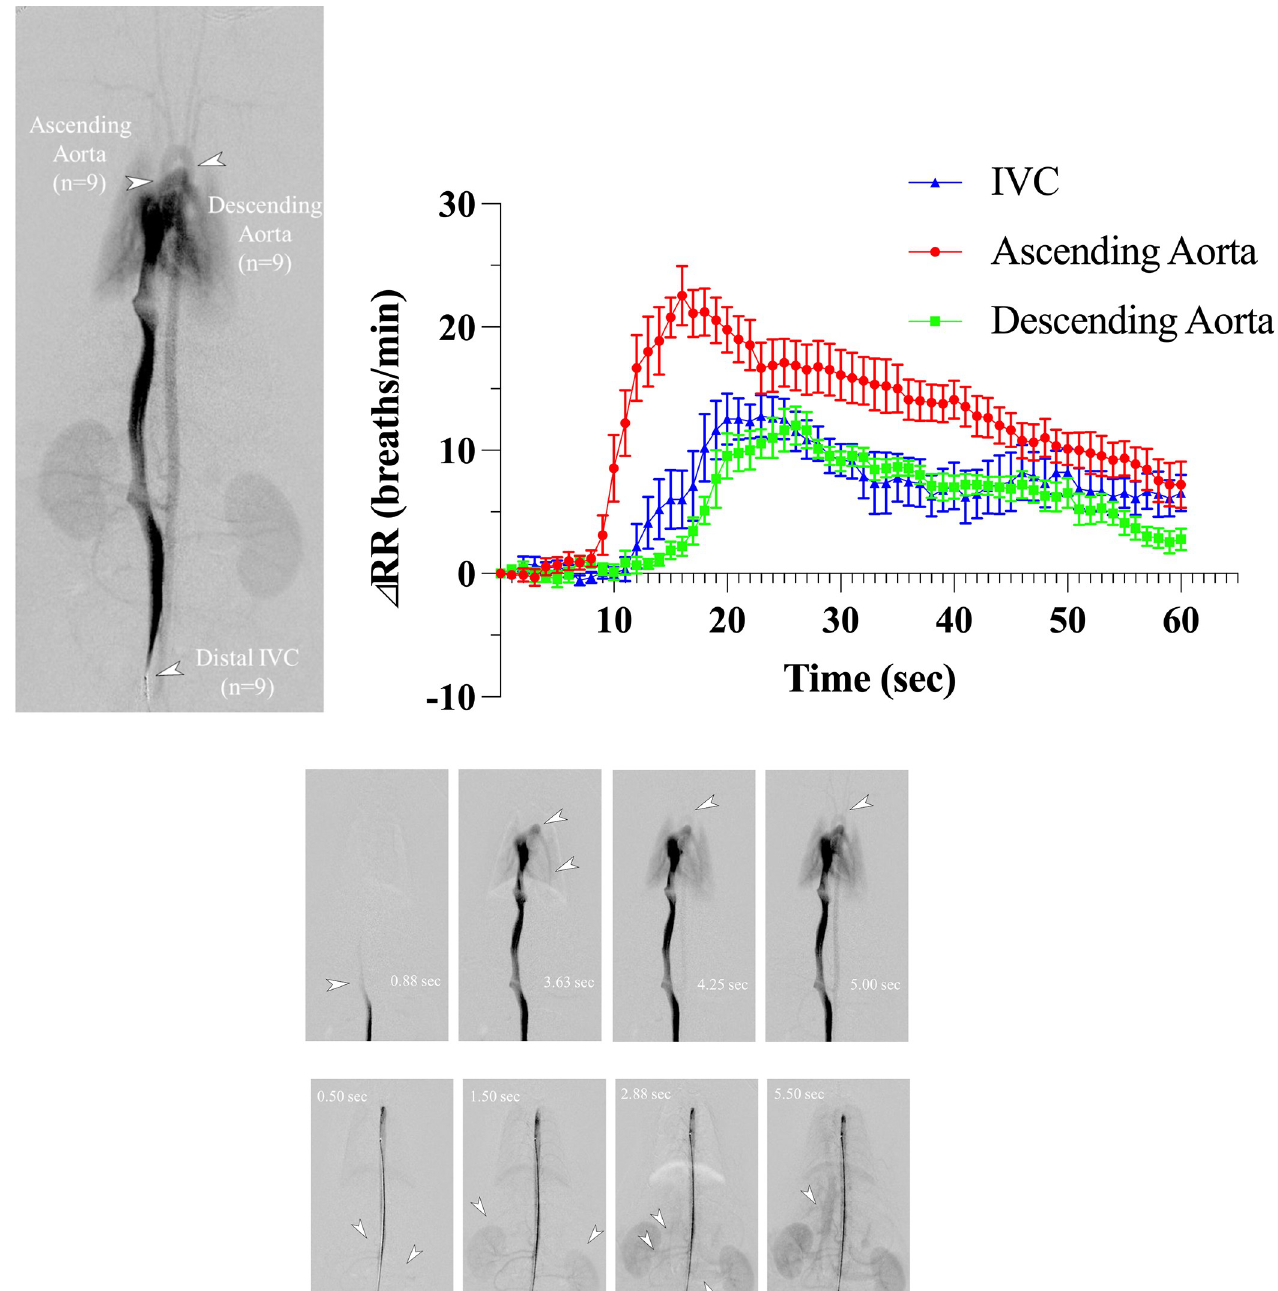
Fig 5. (a) Three injection sites are shown on digital subtraction angiography in rats. (b) Differences in the time course of the respiratory rate among the different injection sites. Note–Error bars represent standard errors (n = 9 rats per group). IVC, gadoxetate disodium injection into the distal inferior vena cava (IVC); Ascending aorta, gadoxetate disodium injection into the ascending aorta; Descending aorta, gadoxetate disodium injection into the descending aorta; Δ RR, change (increase) in the respiratory rate. (c) Representative digital subtraction angiography with distal IVC injection. The arrowhead shows the IVC at the level of the right renal vein at 0.88 sec, proximal and distal pulmonary artery at 3.63 sec, aortic arch branches at 4.25 sec, and aortic arch branches clearly at 5.00 sec. (d) Representative digital subtraction angiography with descending aorta injection. The arrowhead shows the bilateral renal arteries at 0.50 sec, bilateral kidneys at 1.50 sec, bilateral renal veins and IVC at 2.88 sec, and the IVC clearly at 5.50 sec.